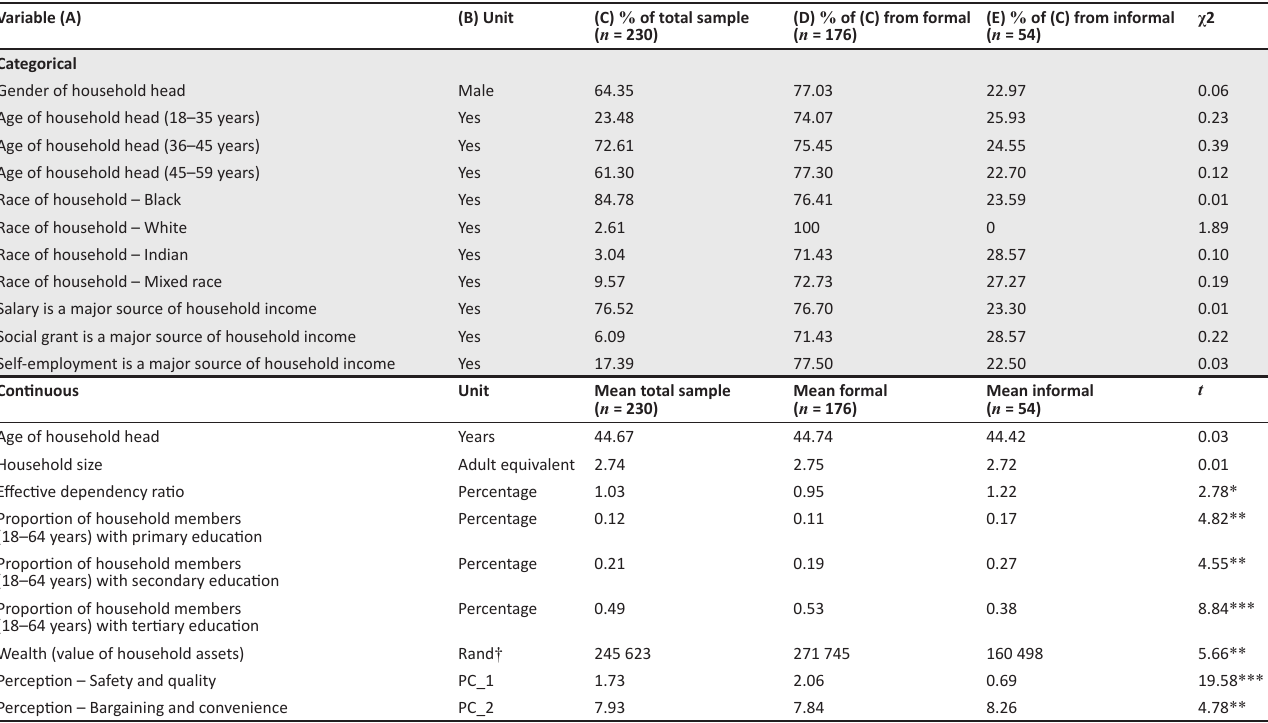
TABLE 1: Descriptive statistics of variables used in the probit regression model, 2015 ( n =